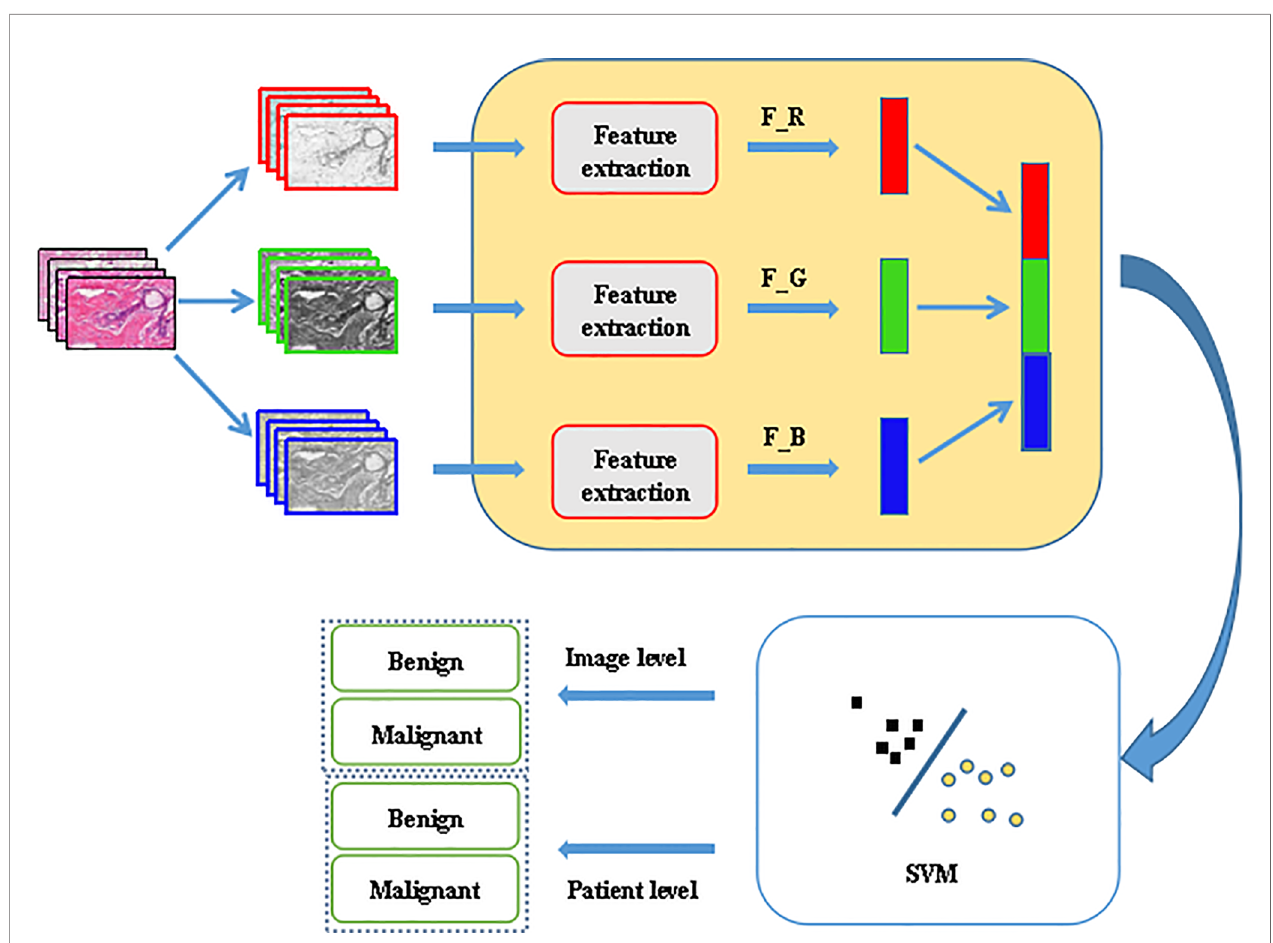
FIGURE 1 | Proposed framework for histopathological image classi fi